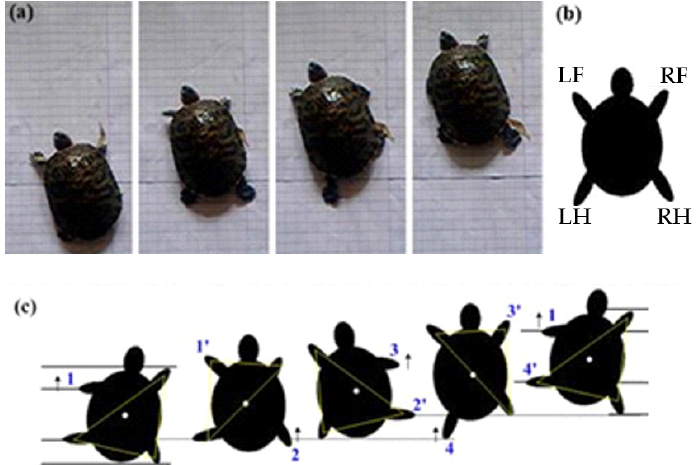
Figure 7. Turtle’s crawling posture. ( a ) the coordinated gait of a tortoise, ( b ) The four legs of the tortoise and their corresponding symbols, ( c ) the step sequence relationship.